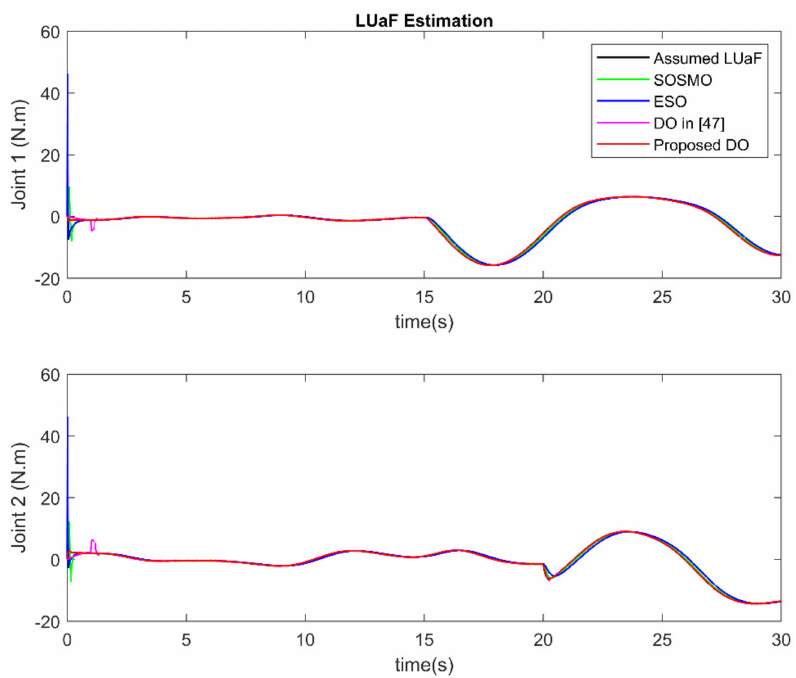
Figure 3. The estimation of LUaF among four observers.